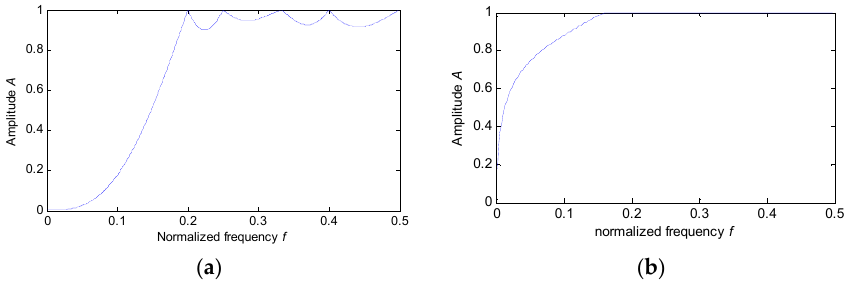
Figure 10. Filtering properties of two methods: ( a ) Proposed EDPWO; ( b ) the Butterworth filter.